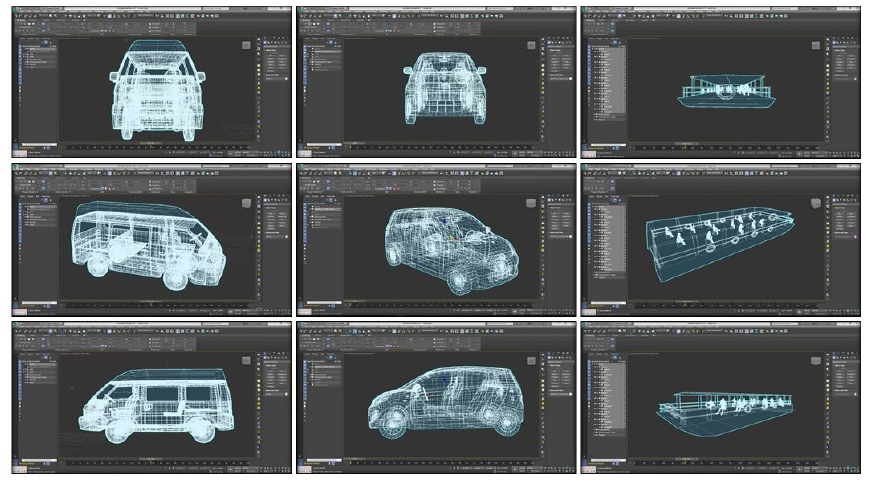
Fig. 3. Modelling